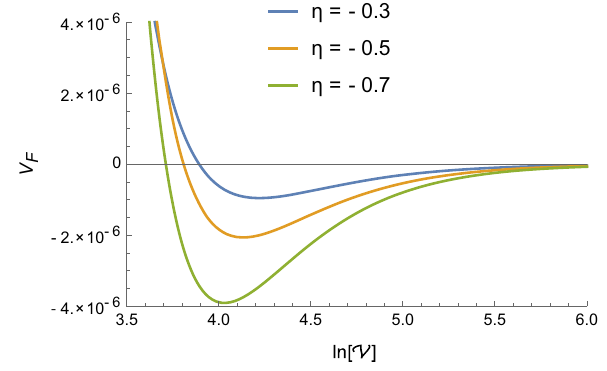
Fig. 1 The scalar potential of Eq. (37) for the choice W 0 = 1